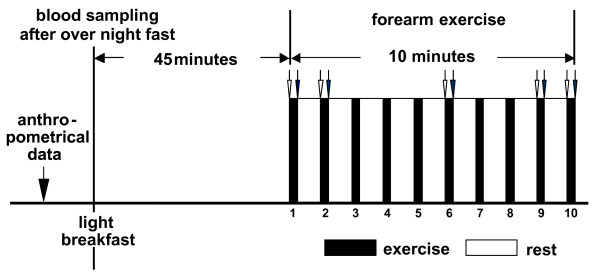
Forearm exercise started 45 min after the first blood sample had been taken. Exercise consisted of 10 maximal bouts of 15 sec separated by a 45 sec rest period. Timing of blood samples are indicated by small arrows (open arrow: pre exercise sample; filled arrow: post exercise sample).